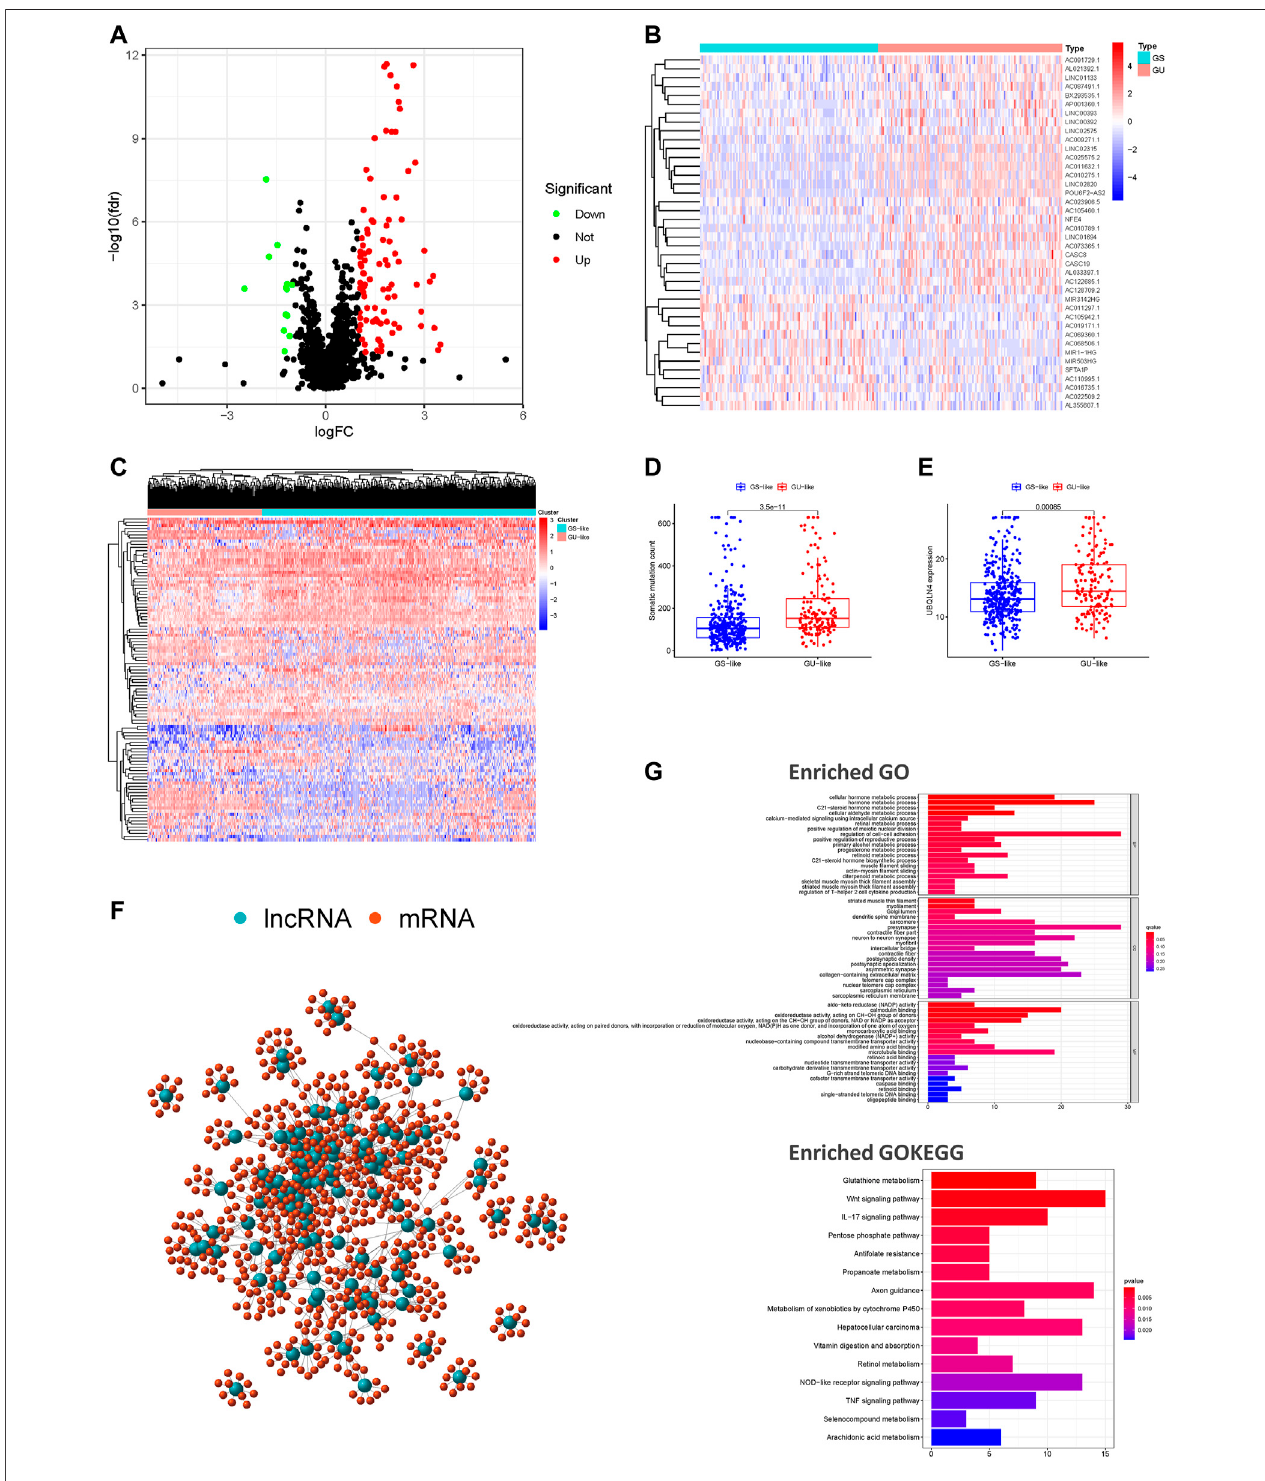
FIGURE 2 | Screening and identifying of genomic instability-related lncRNAs and their functional annotation in patients with HNSCC. (A) Volcano plot of 103 differential expressed lncRNAs between the GU-like and GS-like groups. Upregulated lncRNAs are shown in red on the right, whereas downregulated lncRNAs are shown in green on the left. (B) Heatmap of expression of the top 50 differential lncRNAs, divided into the GS-like groups (blue) and GU-like group (red). (C) An